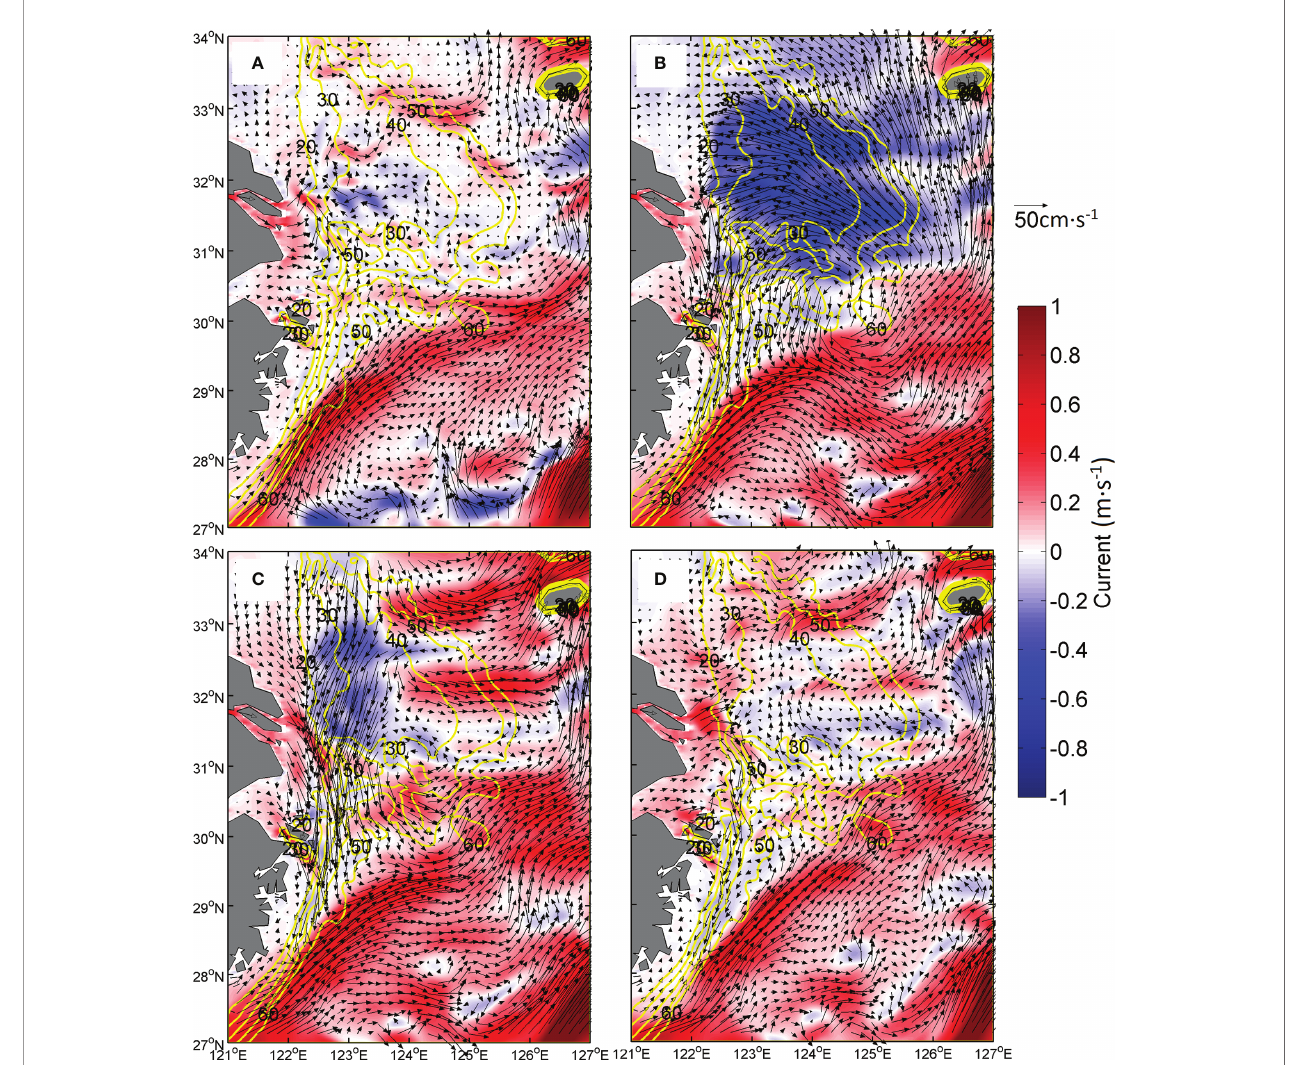
FIGURE 6 | Vectors for daily-mean surface currents superimposed by colors for zonal velocity on August (A) 22, (B) 25, (C) 26, and (D) 28, 2020. Yellow lines indicate